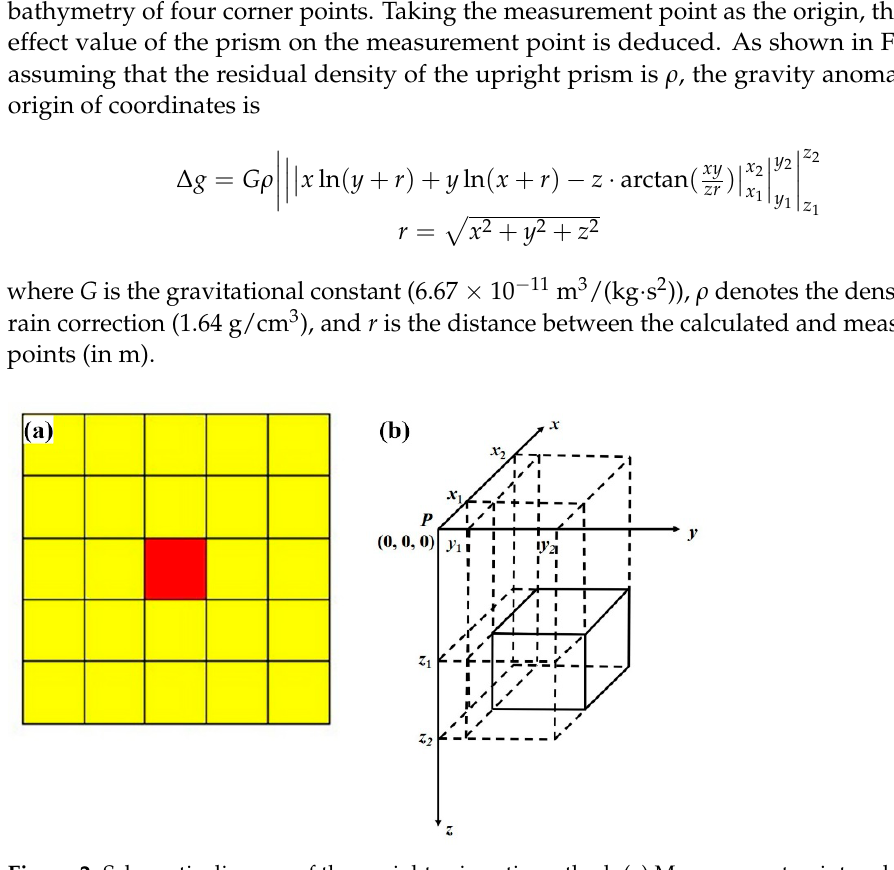
Figure 2. Schematic diagram of the upright prismatic method. ( a ) Measurement point and surround- ing terrain blocks and ( b ) upright prismatic